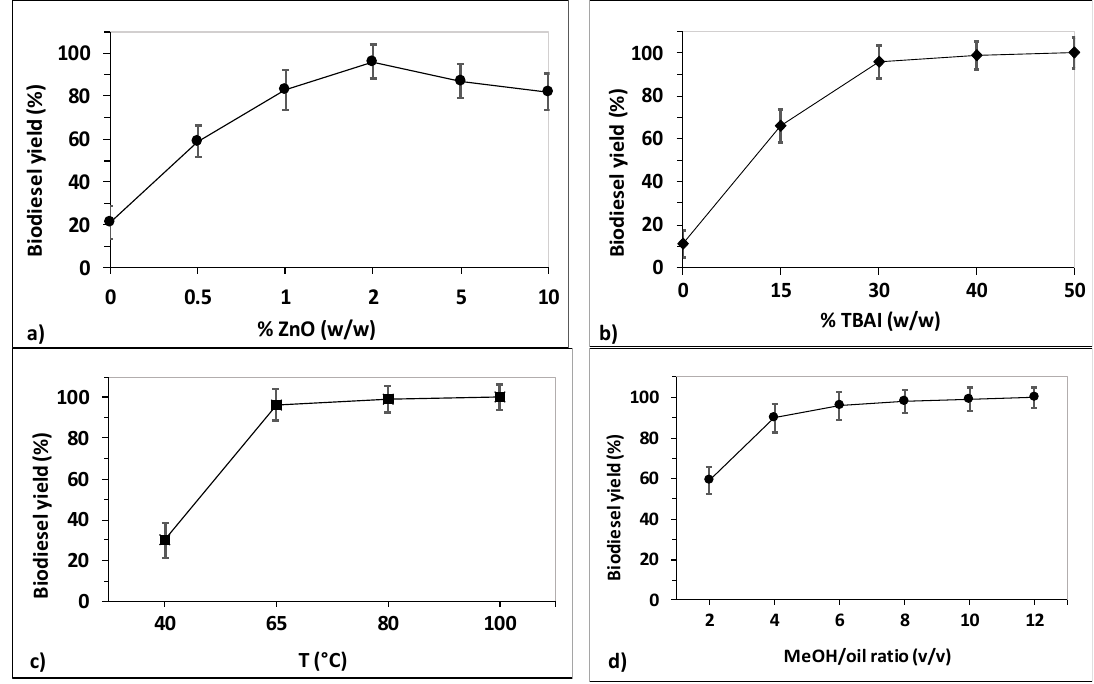
Figure 1. Study of parameters affecting the transesterification of soybean oil (0.5 mL, 0.415 g) with methanol promoted by ZnO/TBAI as catalytic system. ( a ) Effect of ZnO amount: methanol 4 mL, TBAI 123 mg (30% w/w ), at 65 °C for 7 h. ( b ) Effect of TBAI amount: methanol 4 mL, ZnO 9 mg (2% w / w ), at 65 °C for 7 h. ( c ) Effect of temperature: methanol 4 mL, ZnO 9 mg (2% w / w ), TBAI 123 mg (30% w/w ), reaction time 7 h. ( d ) Effect of oil/MeOH ratio: ZnO 9 mg (2% w / w ), TBAI 123 mg (30% w / w ), at 65 °C for 7 h.